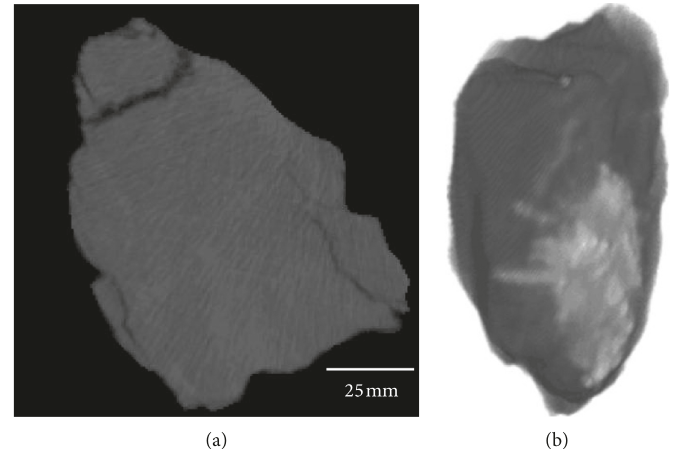
Figure 10: Original CT image and 3D volume-rendering image of the selected coal particle, respectively.